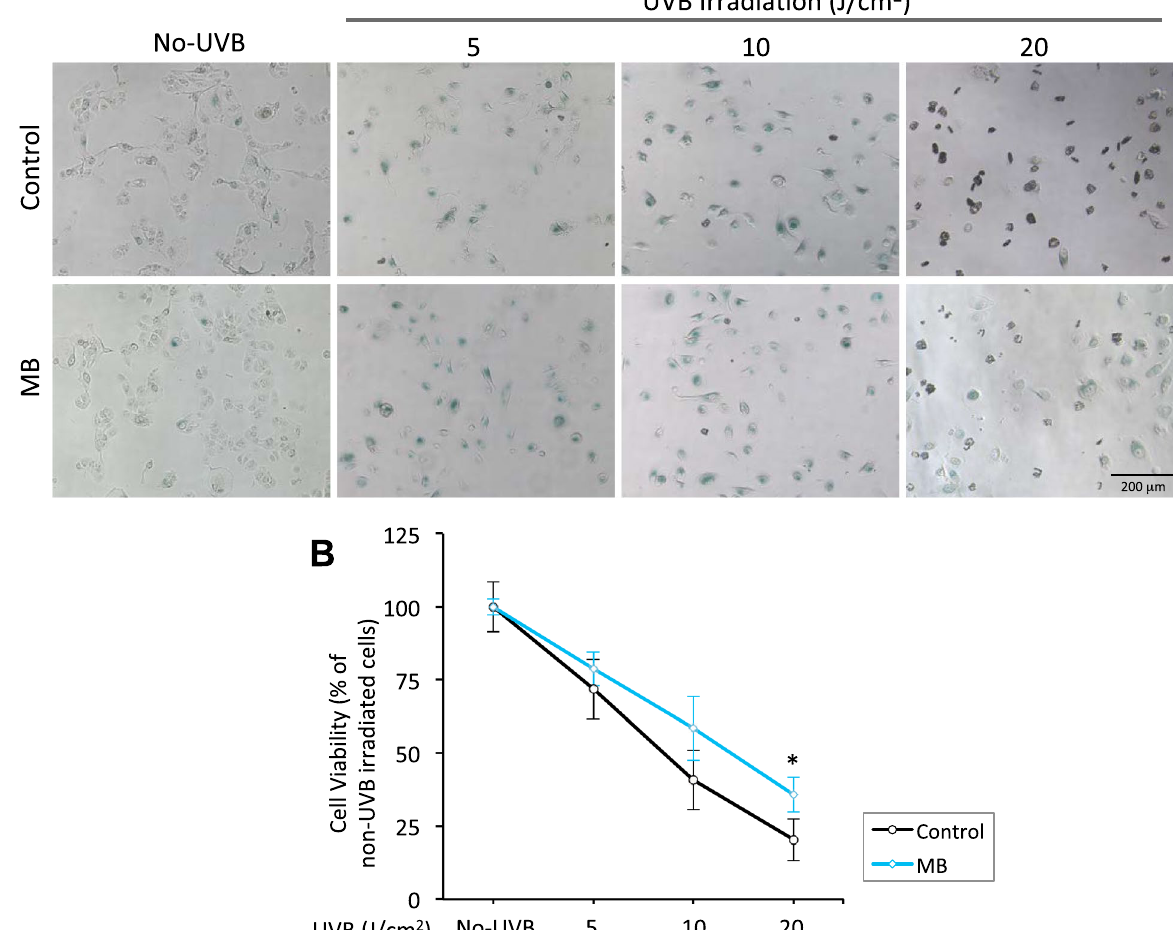
Figure 2. MB prevents human keratinocytes from UVB-induced cell death. ( A ) Representative images of senescence-associated β-galactosidase (SA-β-gal) staining in human keratinocytes 5 days after UVB irradiation at 0, 5, 10, and 20 J/cm 2 . The cells were pretreated with Control (PBS) or 100 nM MB for two weeks before UVB irradiation. Scale bar = 200 μm. ( B ) AlarmaBlue cell viability assay in Control and MB-treated human keratinocytes at day five after UVB exposure at denoted dosages. The cells were pretreated with Control (PBS) or 100 nM MB for two weeks before UVB irradiation. * p < 0.05 MB versus